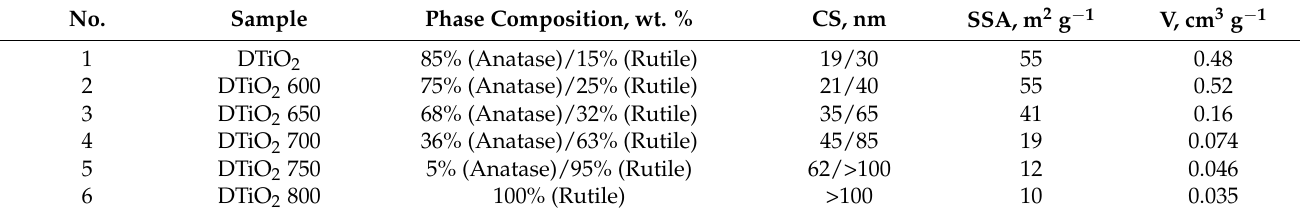
Figure 2. XRD patterns of the samples based on ( a ) TiO 2 Hombifine N and ( b ) TiO 2 Degussa P25. Table 1. Structural and textural characteristics of calcined Degussa P25